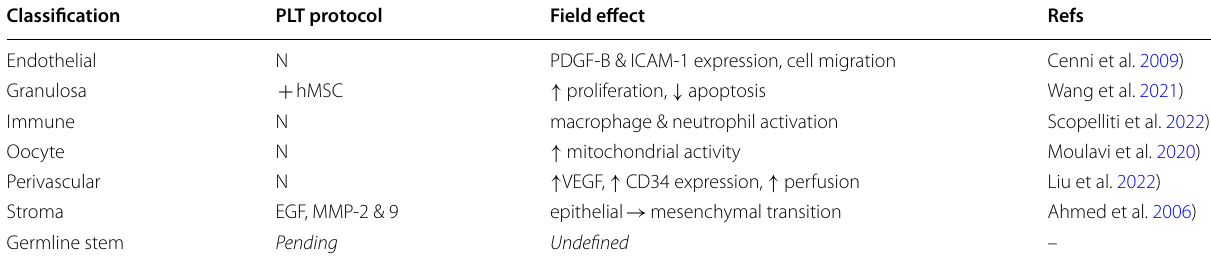
Table 1 Ovary components by cell type and corresponding response to platelet-rich plasma or platelet (PLT) derivatives, based on reported corollary observations in each group